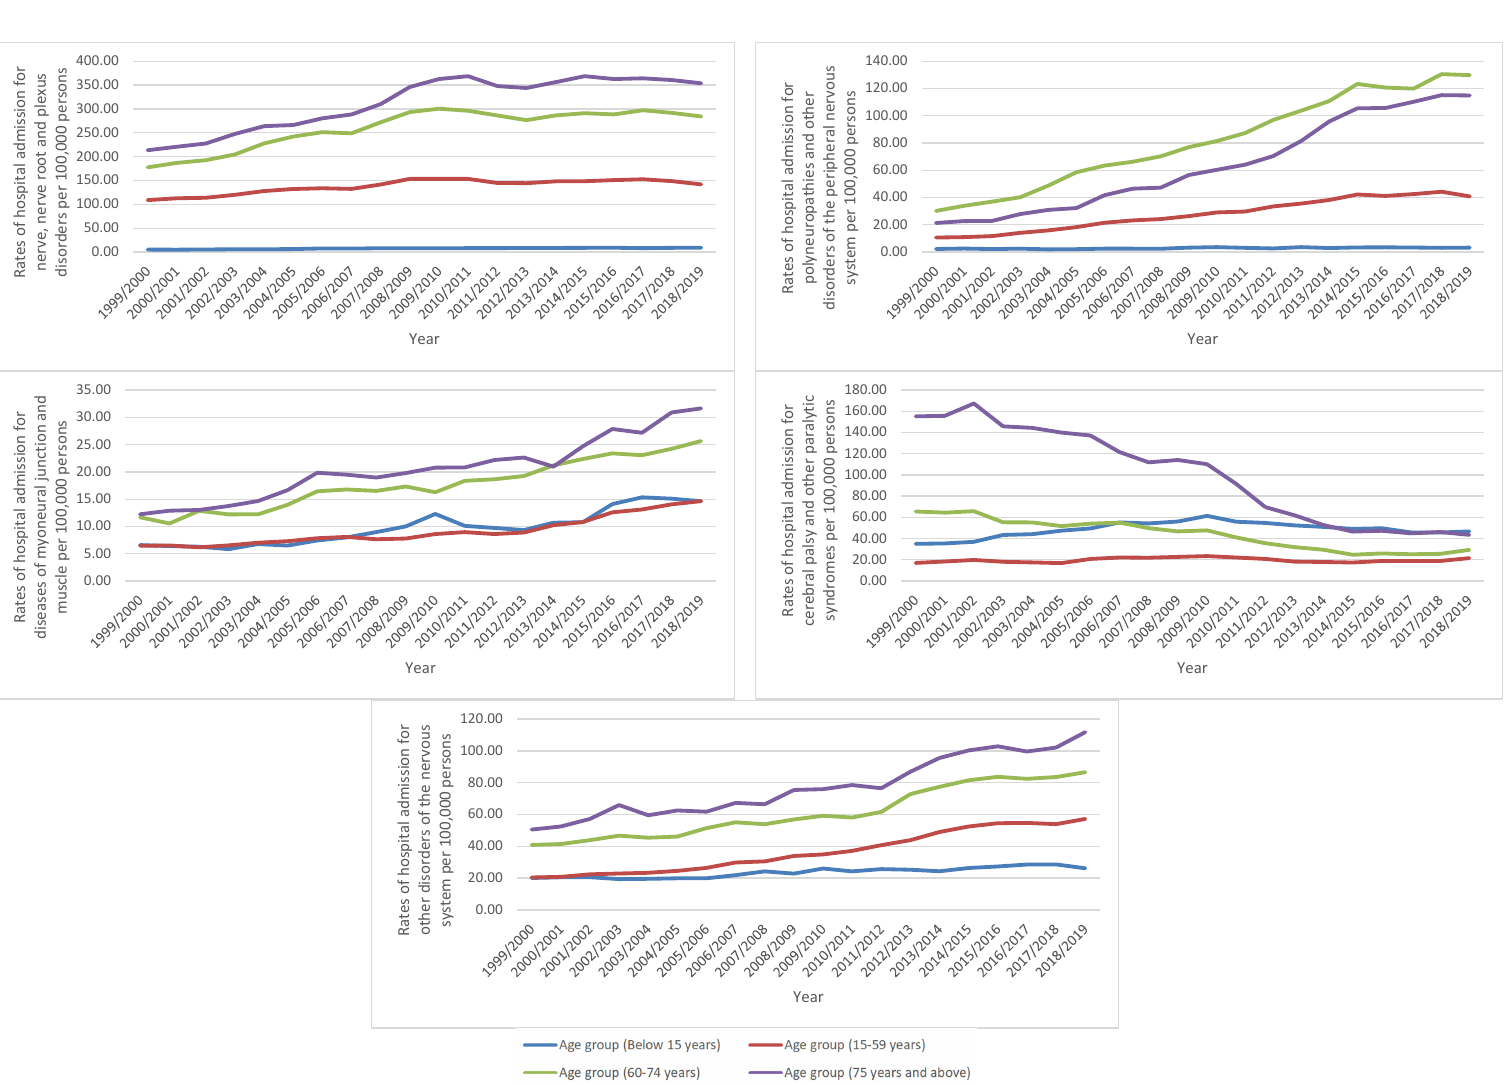
Figure 5. Hospital admission rates for diseases of the nervous system in England and Wales stratified by age group.